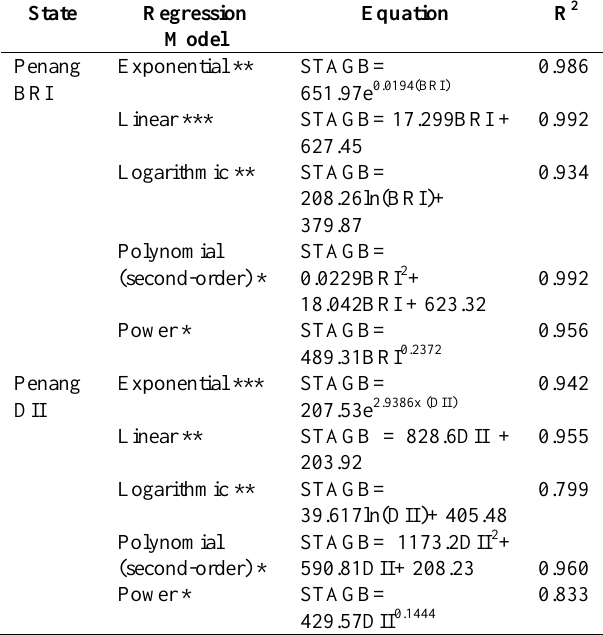
Table 4. Logistic models established on STAGB versus BRI and STAGB against DII acquired with Landsat ETM+.